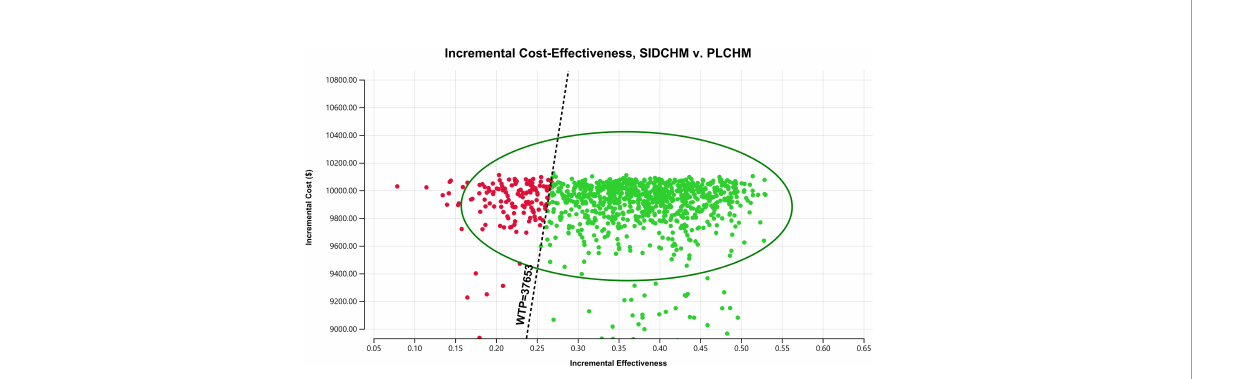
FIGURE 3 A probabilistic scatter plot of the ICER between the SIDCHM group and the PLCHM group. Each point means the ICER for 1 simulation. Ellipses are used to indicate 95% con fi dence intervals. Points that lie below the ICER threshold represent cost-effective simulations. ICER, incremental cost-effectiveness ratio; PLCHM, placebo plus chemotherapy; SIDCHM, sintilimab plus chemotherapy; WTP,